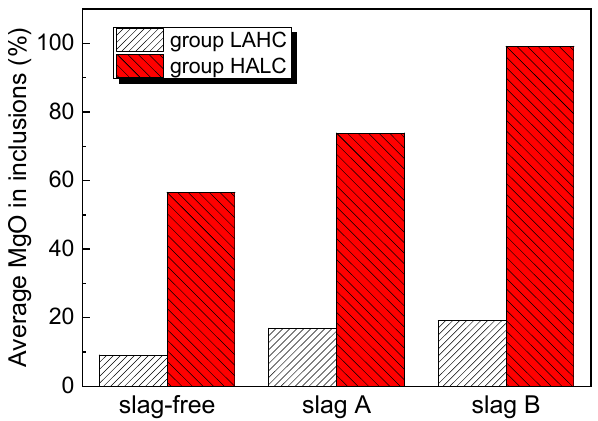
Figure 3. Average MgO content in inclusions after quasi-equilibrium experiments.